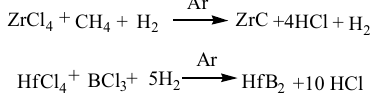
Table 1: Precursors and the conditions needed for the deposition of non - oxide ceramics [ 44 ]